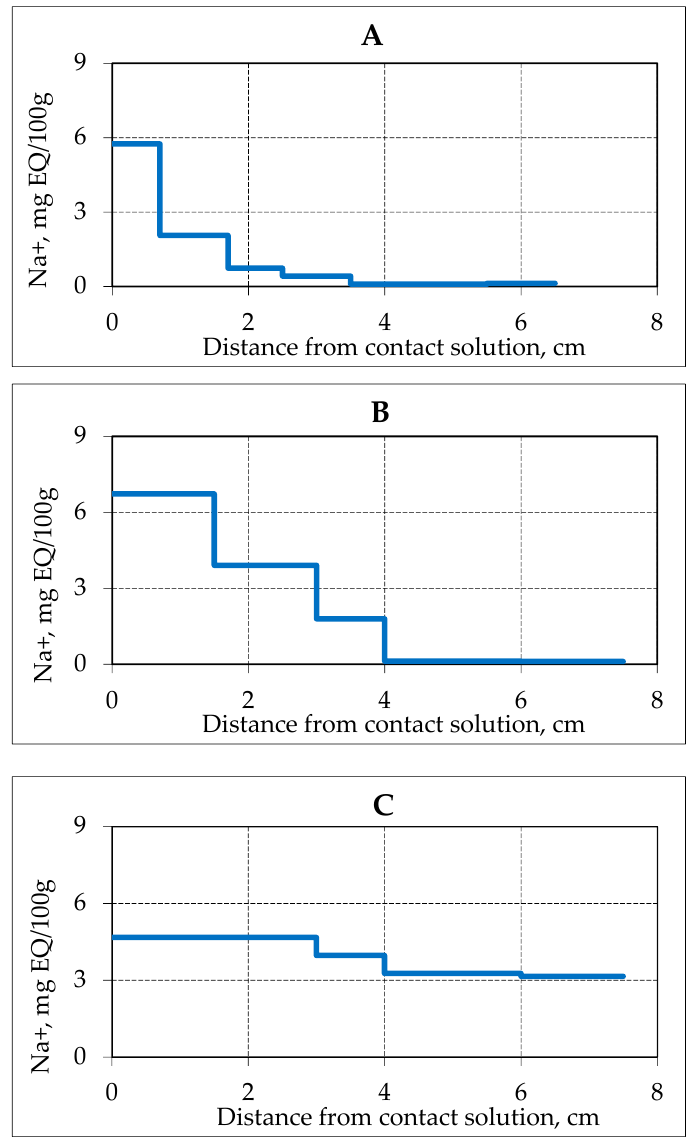
Figure 6. Accumulation of Na + ions in samples of frozen hydrate saturated sand (sand 2, W = 16%) over time when interacting with 0.2 N NaCl solution at a temperature − 2.5 ◦ C. ( A – C )—the time of interaction with salt solution, respectively, 0.3, 0.9 and 2.6 h.